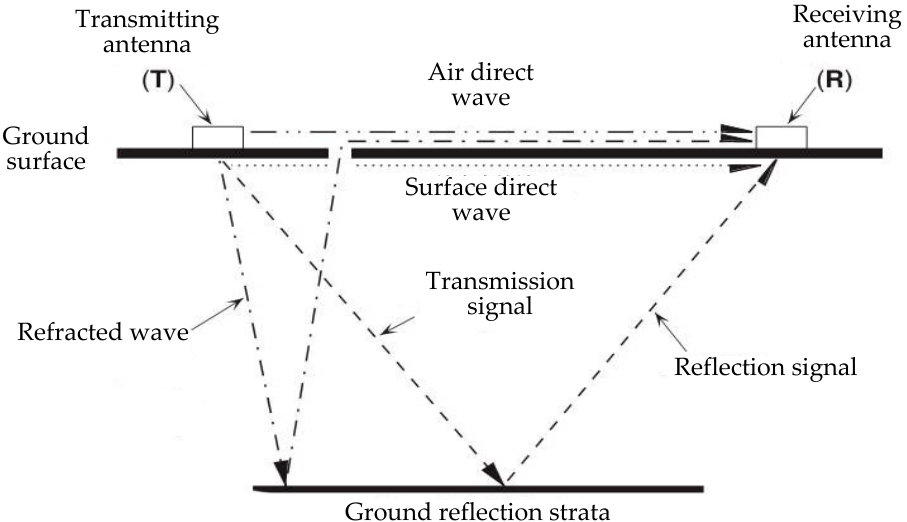
Figure 18. Propagation principles of radar waves in ground medium.